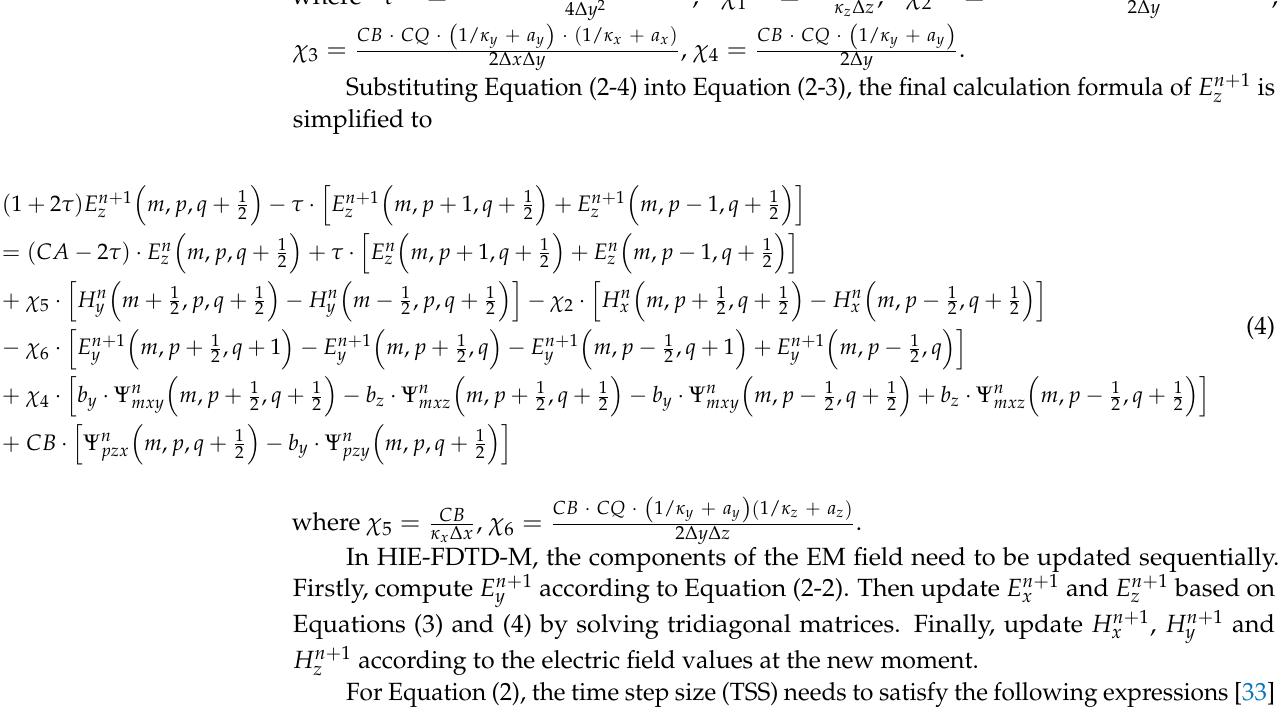
according to the electric field values at the new